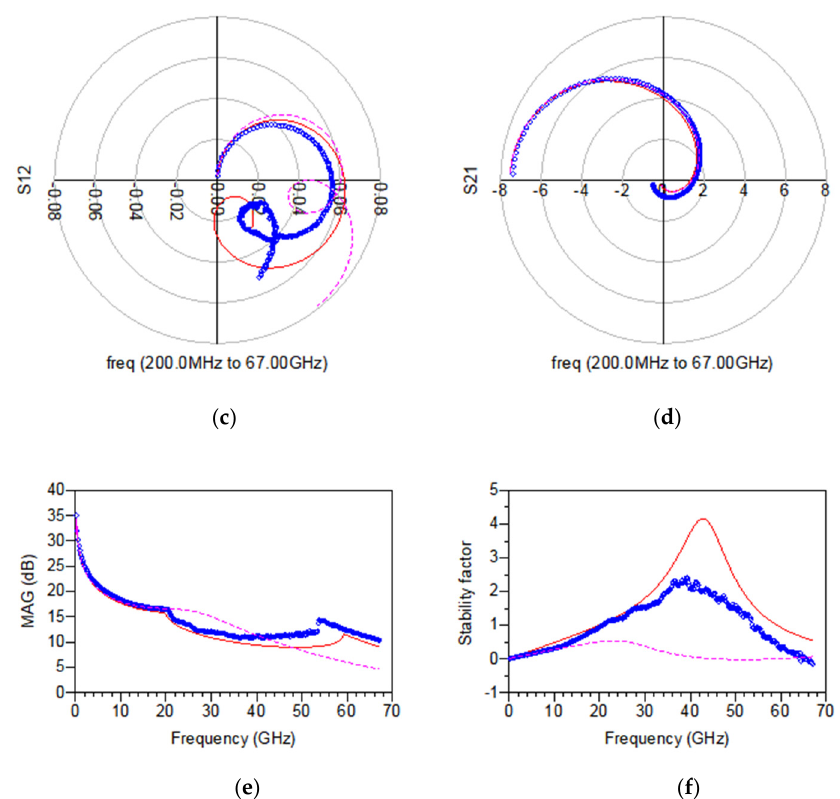
Figure 12. Comparison of ( a ) S11, ( b ) S22, ( c ) S12, ( d ) S22, ( e ) MSG/MAG, and ( f ) stability factor among the measurement (blue circle), the conventional model (pink dashed line), and the proposed model (red line) from 0.2 to 67 GHz under V ds = 20 V, V gs = -1.2 V.